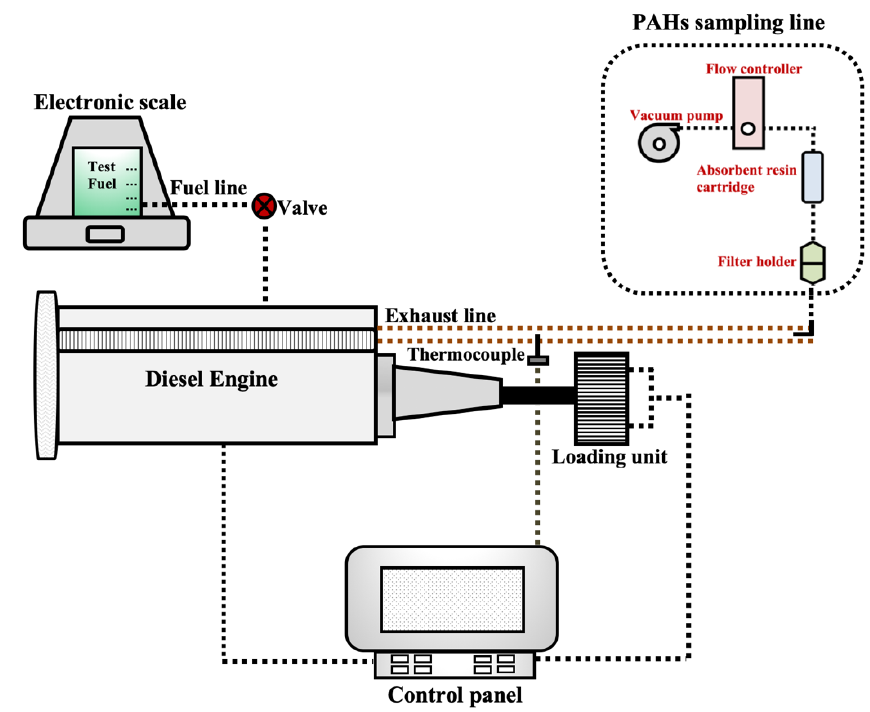
Figure 1. Experimental setup and PAH Sampling.